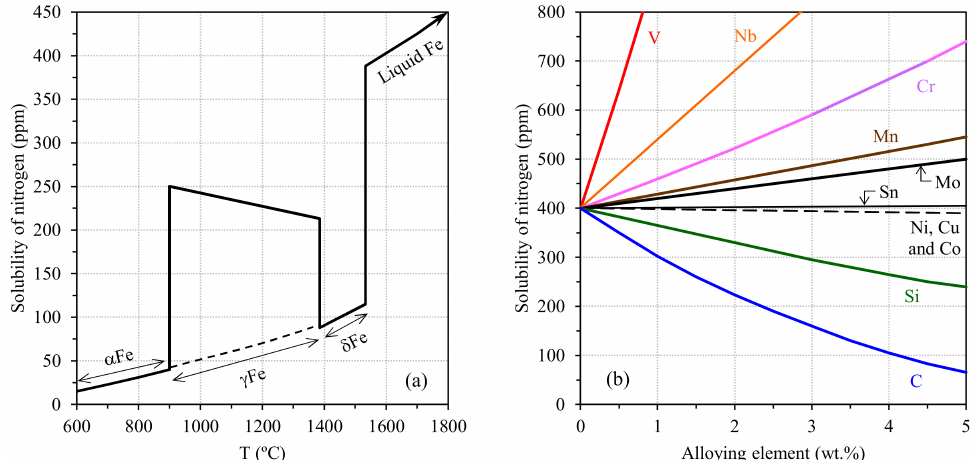
Figure 4. ( a ) Solubility of nitrogen in pure liquid iron at one atmosphere pressure (Adapted with permission from ref. [5]. Copyright 1979 American Foundry Society); ( b ) effect of various elements on nitrogen solubility in pure liquid iron at one atmosphere pressure and 1600 ◦ C (Adapted with permission from ref. [6]. Copyright 1953